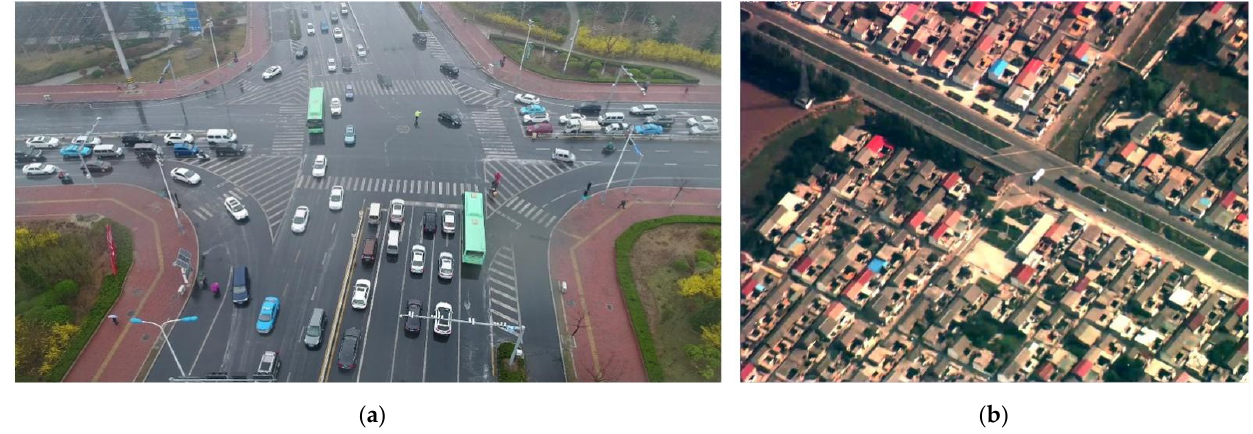
Figure 1. Comparison of UAV images at different heights. ( a ) An example of the low altitude UAV image dataset UAVDT [7], and ( b ) is an example of the mid-to-high altitude UAV image we estab-